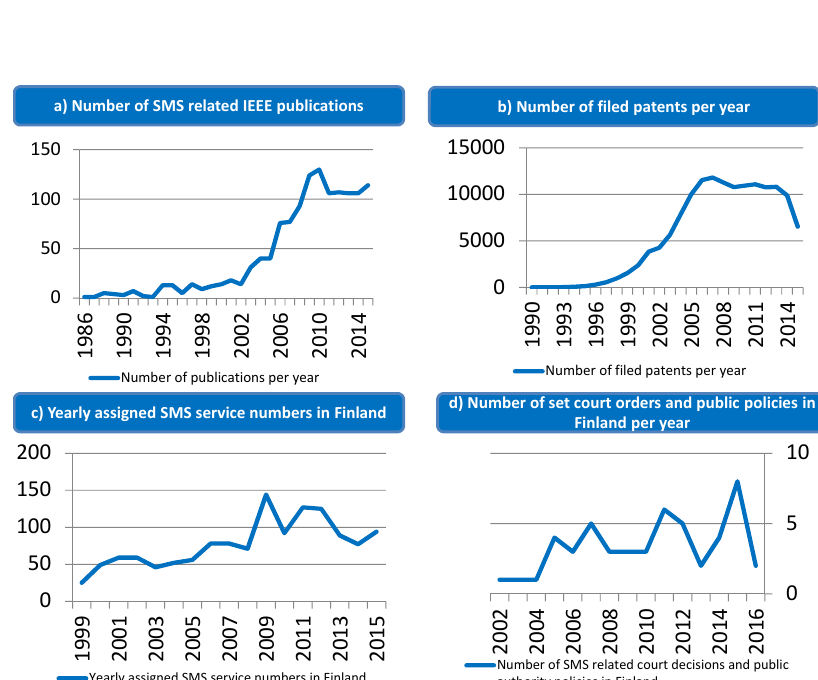
Fig. 3. Statistics related to SMS from different layers of the Disruption Framework